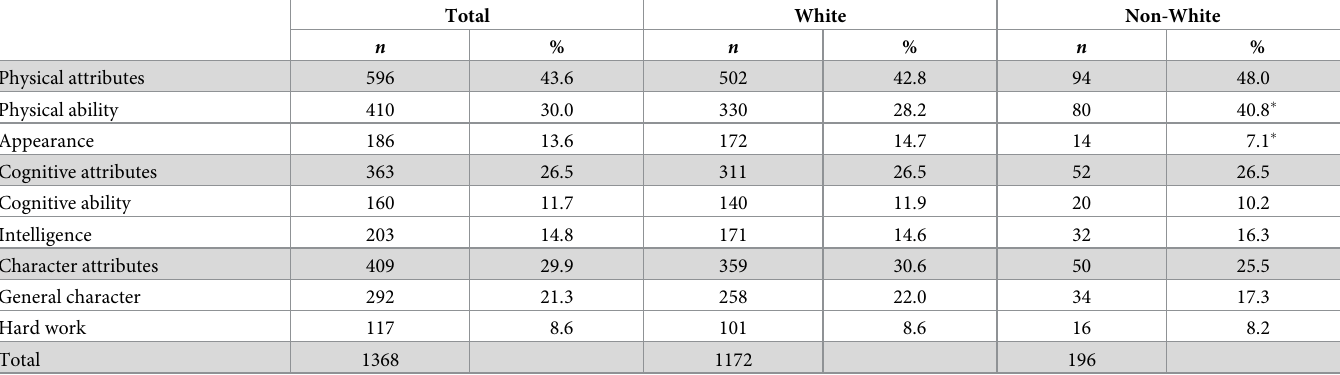
Table 2. Proportion of statements received by race for each main attribute category and